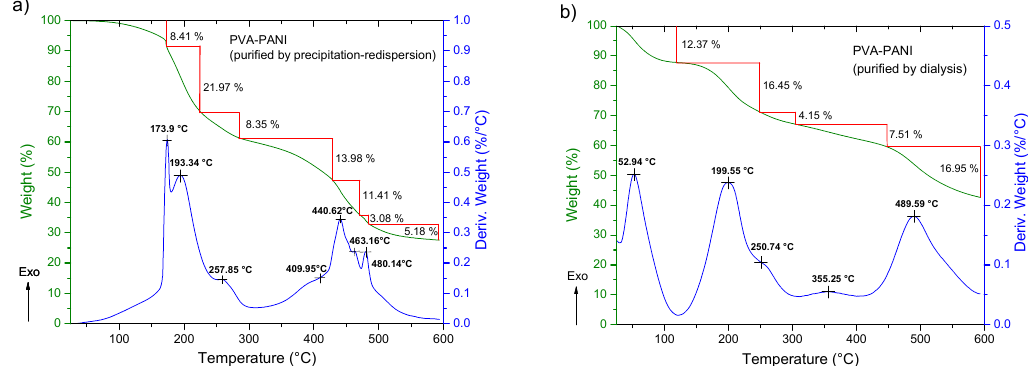
Molecules 2018 , 23 , x FOR PEER REVIEW Figure 10. TGA-DTG of PVA–PANI purified by ( a ) precipitation–redispersion and ( b ) dialysis.